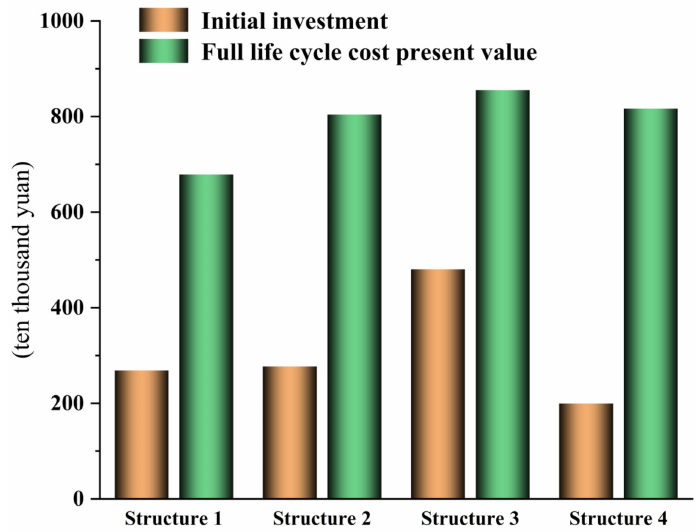
Figure 8. Initial investment and present value of life-cycle cost for four pavement structures.